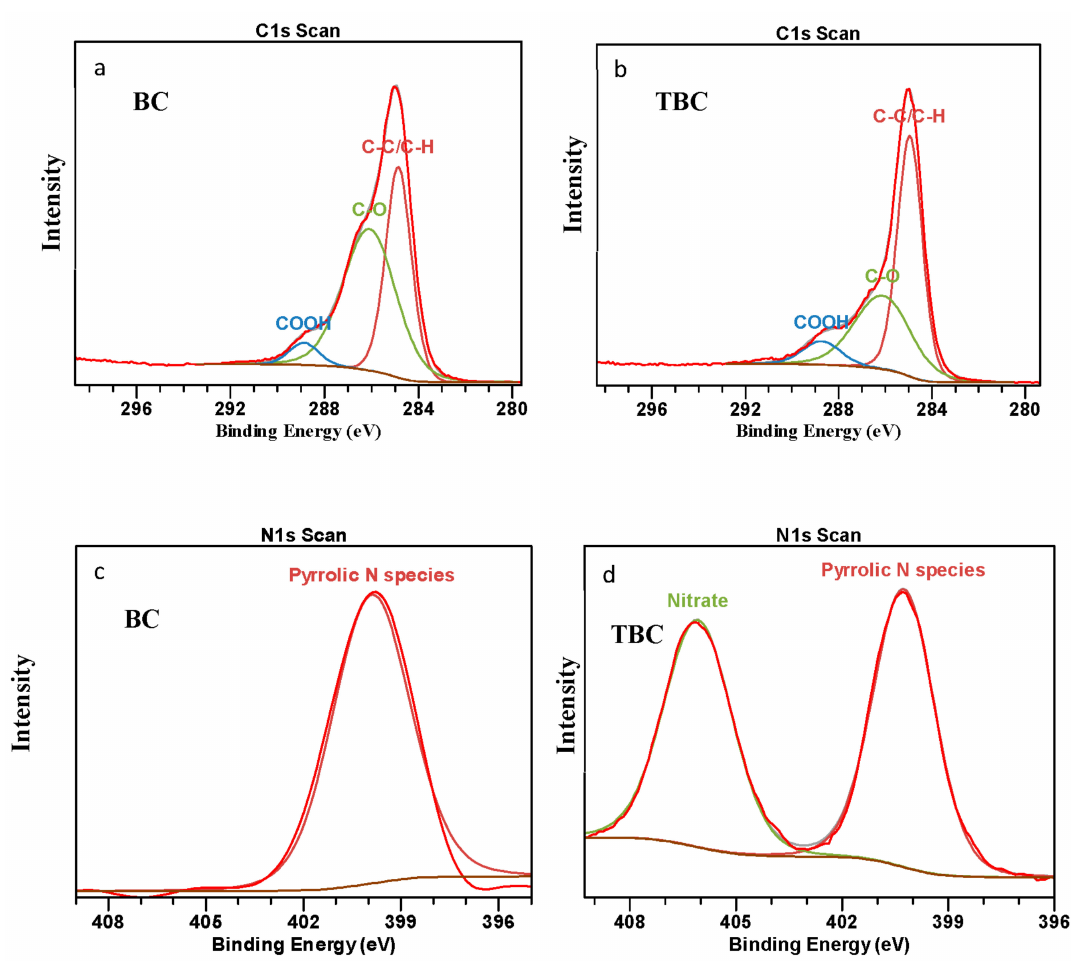
Figure 4. X-ray photoelectron spectroscopy spectra showing the C1s spectrum of ( a ) wood biochar (BC) and ( b ) treated biochar (TBC); and N1s spectrum of ( c ) wood biochar (BC) and ( d ) treated biochar